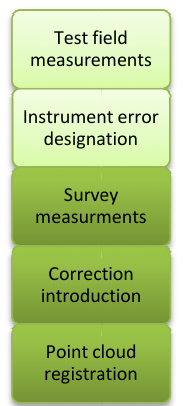
Figure 8. Proposed workflow